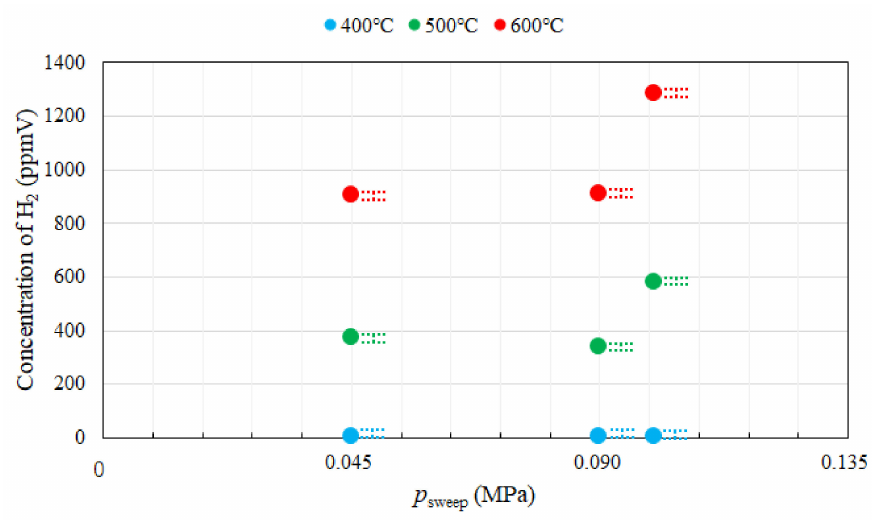
Figure 4. Impact of concentration of H 2 at the outlet of the reaction chamber and p sweep with change in reaction temperature. (CH 4 :CO 2 = 1.5:1).